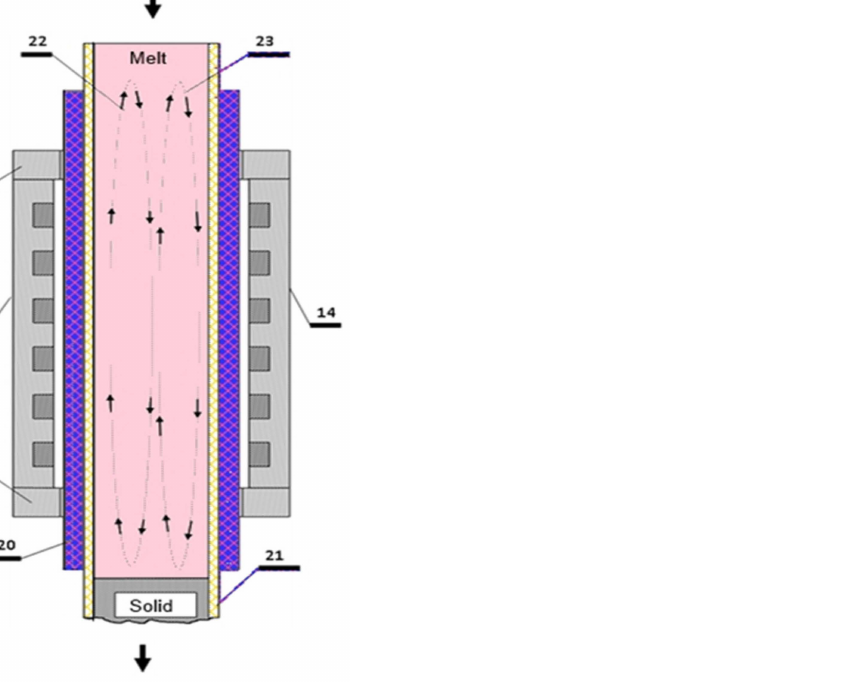
Figure 11. The image of melt flow developed by the TMF twin inductor during the solidification process in the longitudinal section of solidification unit. “22”: direction of melt flow produced by “A” side of inductor. “23”: direction of melt flow produced by “B” side of